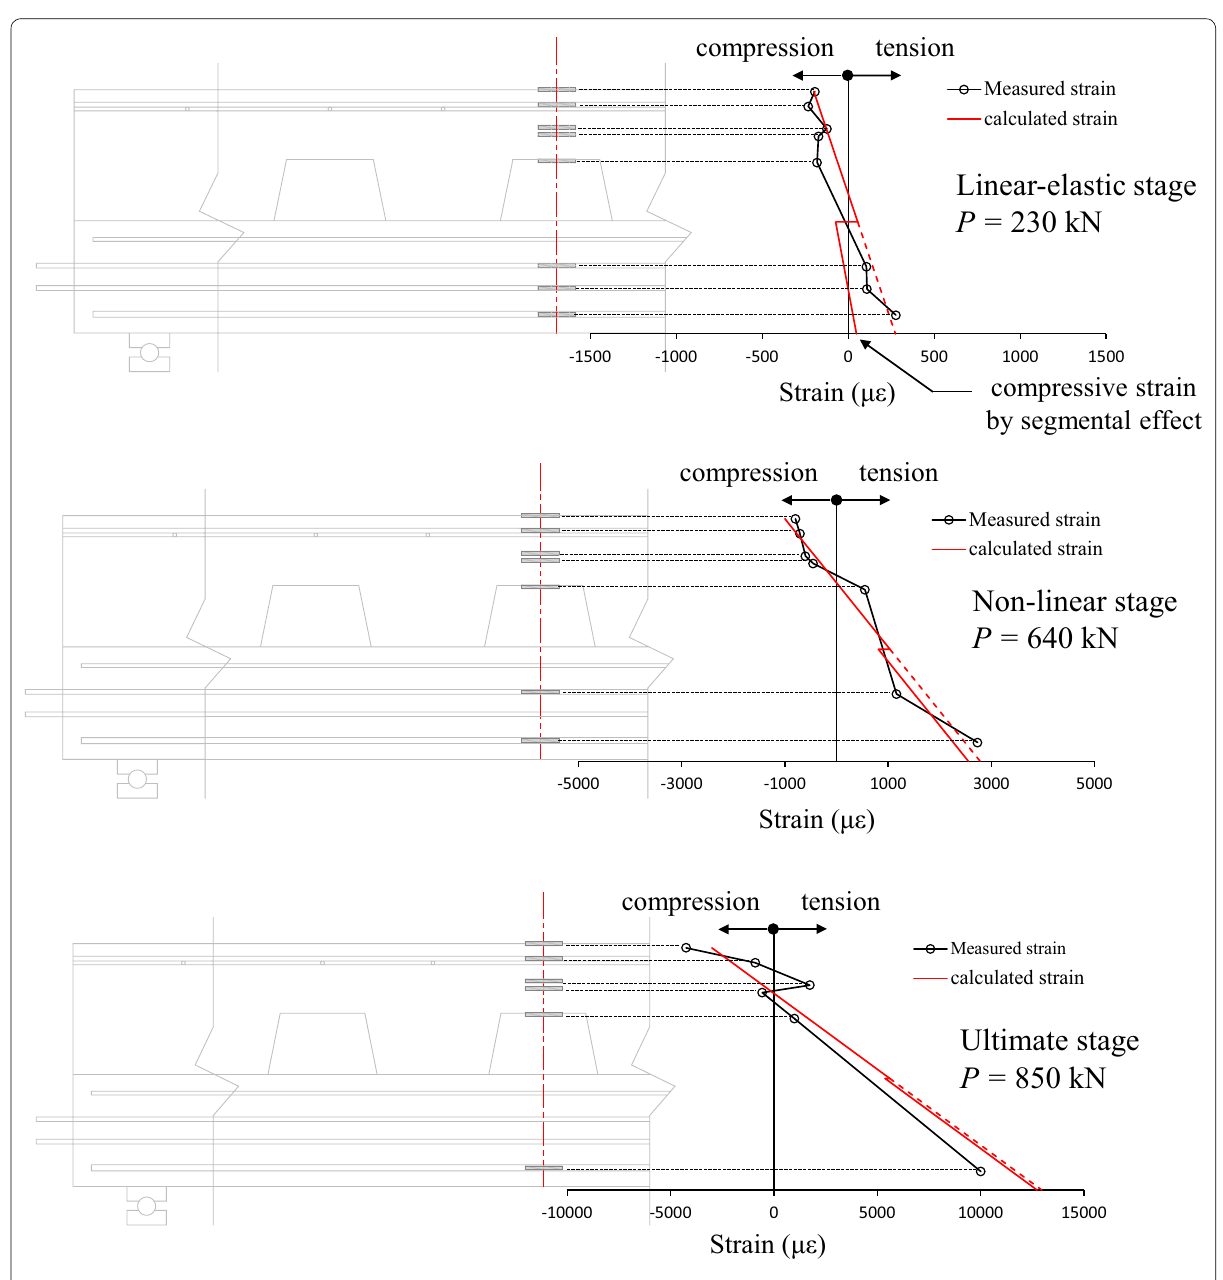
Fig. 18 Comparison of measured and calculated sectional strain